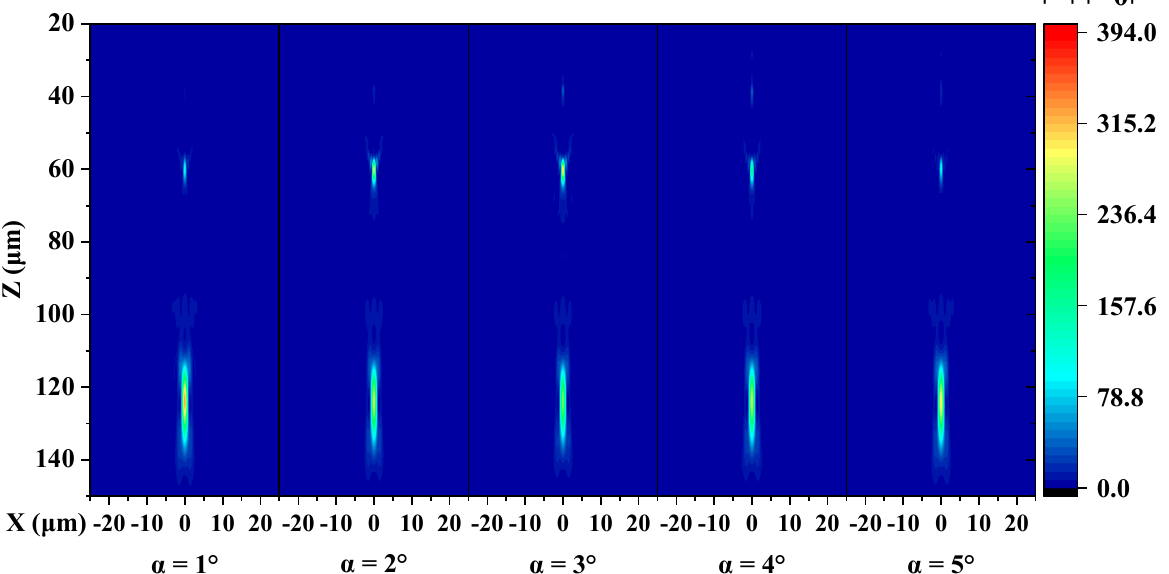
Figure 6. Simulated relative E-field intensity profiles in the xz-plane of metalenses composed of units with different values of α.